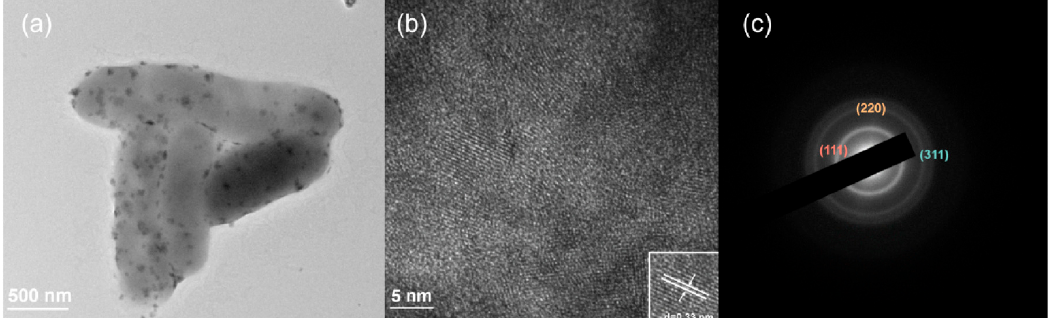
Figure 2. Characterization of the CdS- Shewanella oneidensis hybrids self-assembled under pseudo anaerobic conditions: ( a ) TEM image of nano-bacteria hybrids showing self-biomineralized CdS nanocrystals deposited on the cell surface; ( b ) Electron diffraction pattern of the CdS nanocrystals in nano-bacteria hybrids from HRTEM results. The d-spacing of the CdS nanoparticles is 3.3 Å which aligns with the (111) plane of face-centered cubic CdS; ( c ) SAED analysis of the CdS nanocrystals in nano-bacteria hybrids. The indices are assigned to the diffraction rings in accordance with the face-centered cubic lattice of CdS.